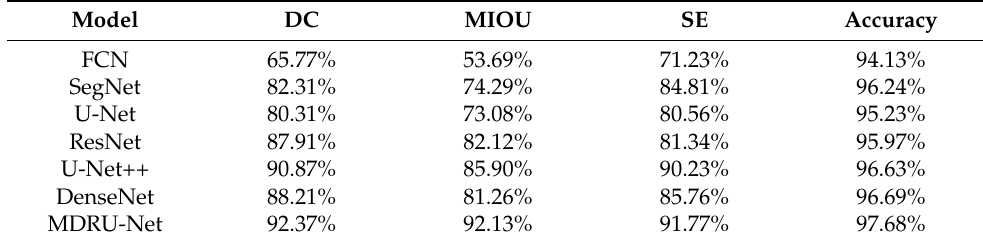
Table 2. Comparative experimental